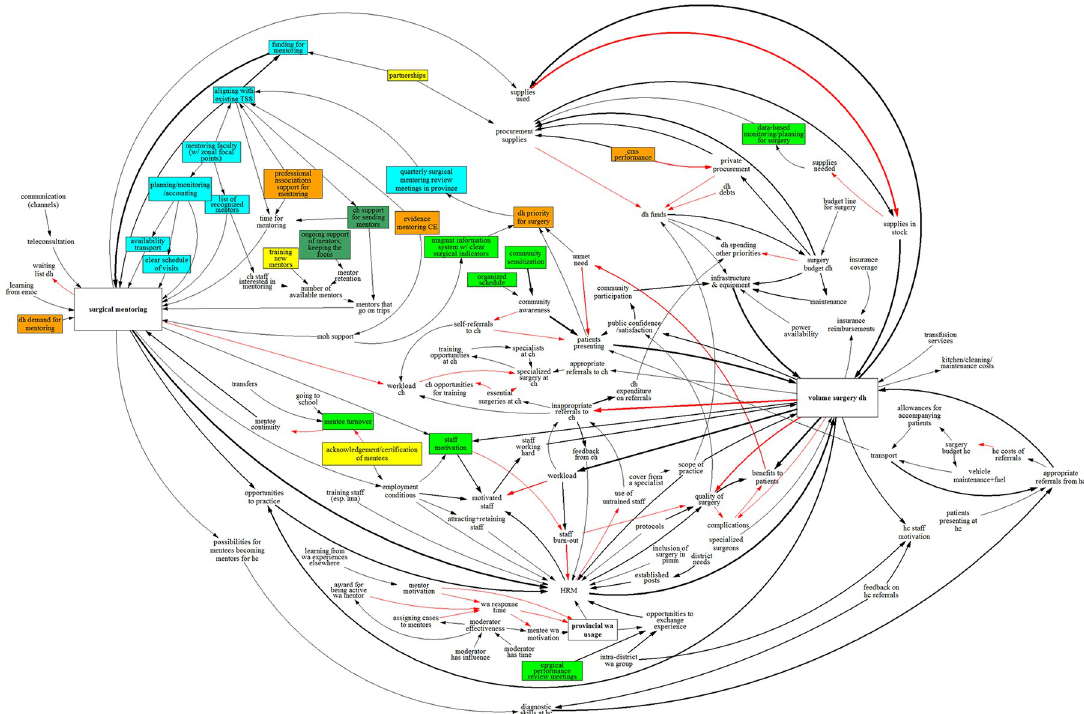
Fig 12. Integrated causal loop diagram showing the recommendations for sustaining surgical mentoring. Black arrows denote positive links, while red arrows denote negative links. The thickness of arrows indicates how often links were mentioned across workshops. As there are many feedback loops the notation for them has been omitted for